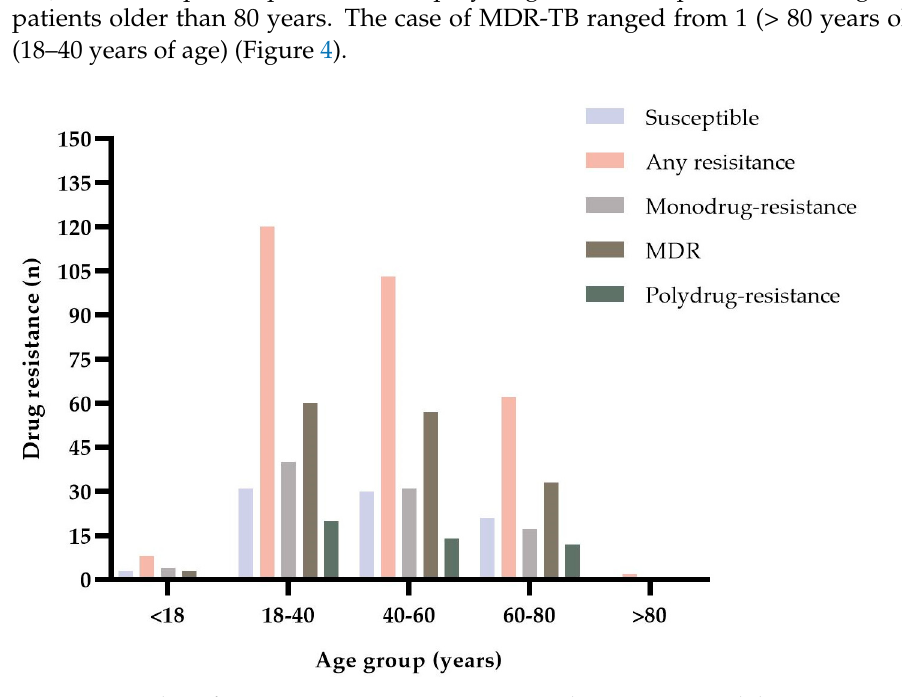
Table 4. Mutations in drug resistance-related genes.